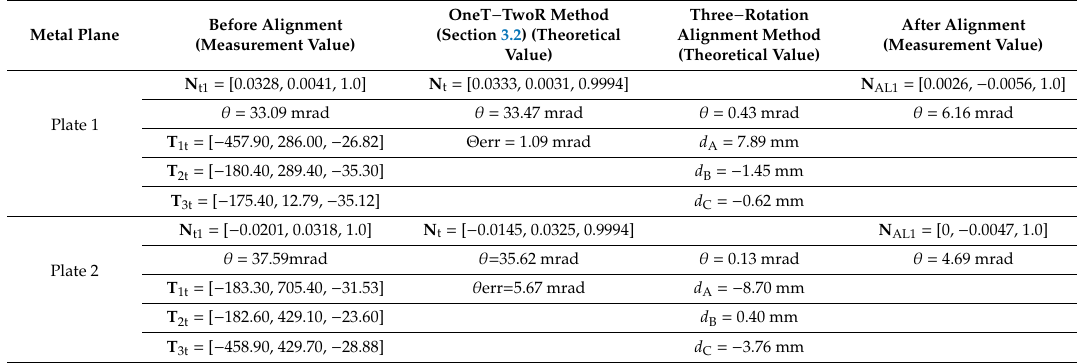
Table 3. Experimental data from the facet alignment of the metal plane using the three-rotation alignment method.